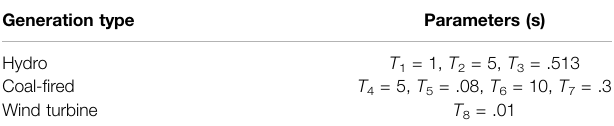
TABLE 2 | Transfer function parameters of AGC units. Generation